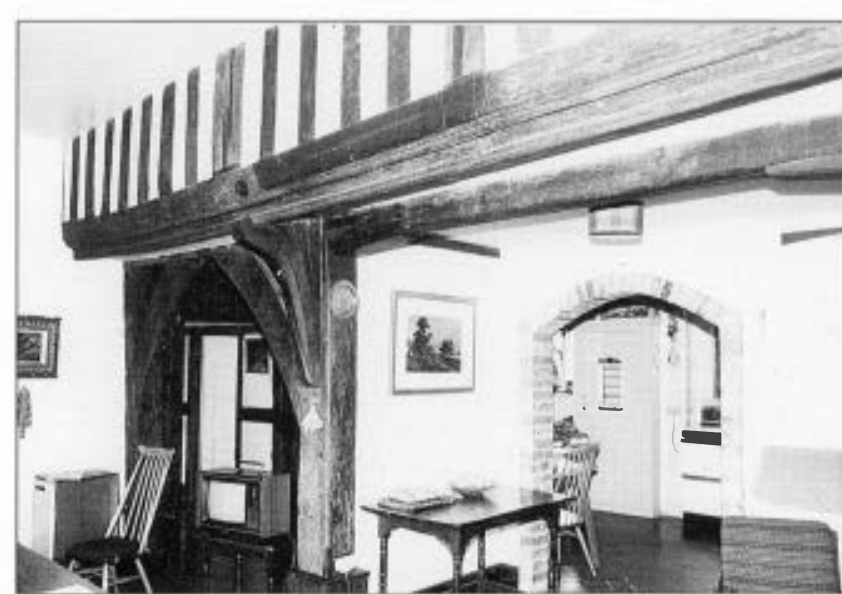
Figure 4 The original southern external wall (upper left) of the kitchen at Comphurst, now visible within a later addition. The ground-floor section of the external wall has been removed, but mortices in the remaining timbers provide evidence of its design.